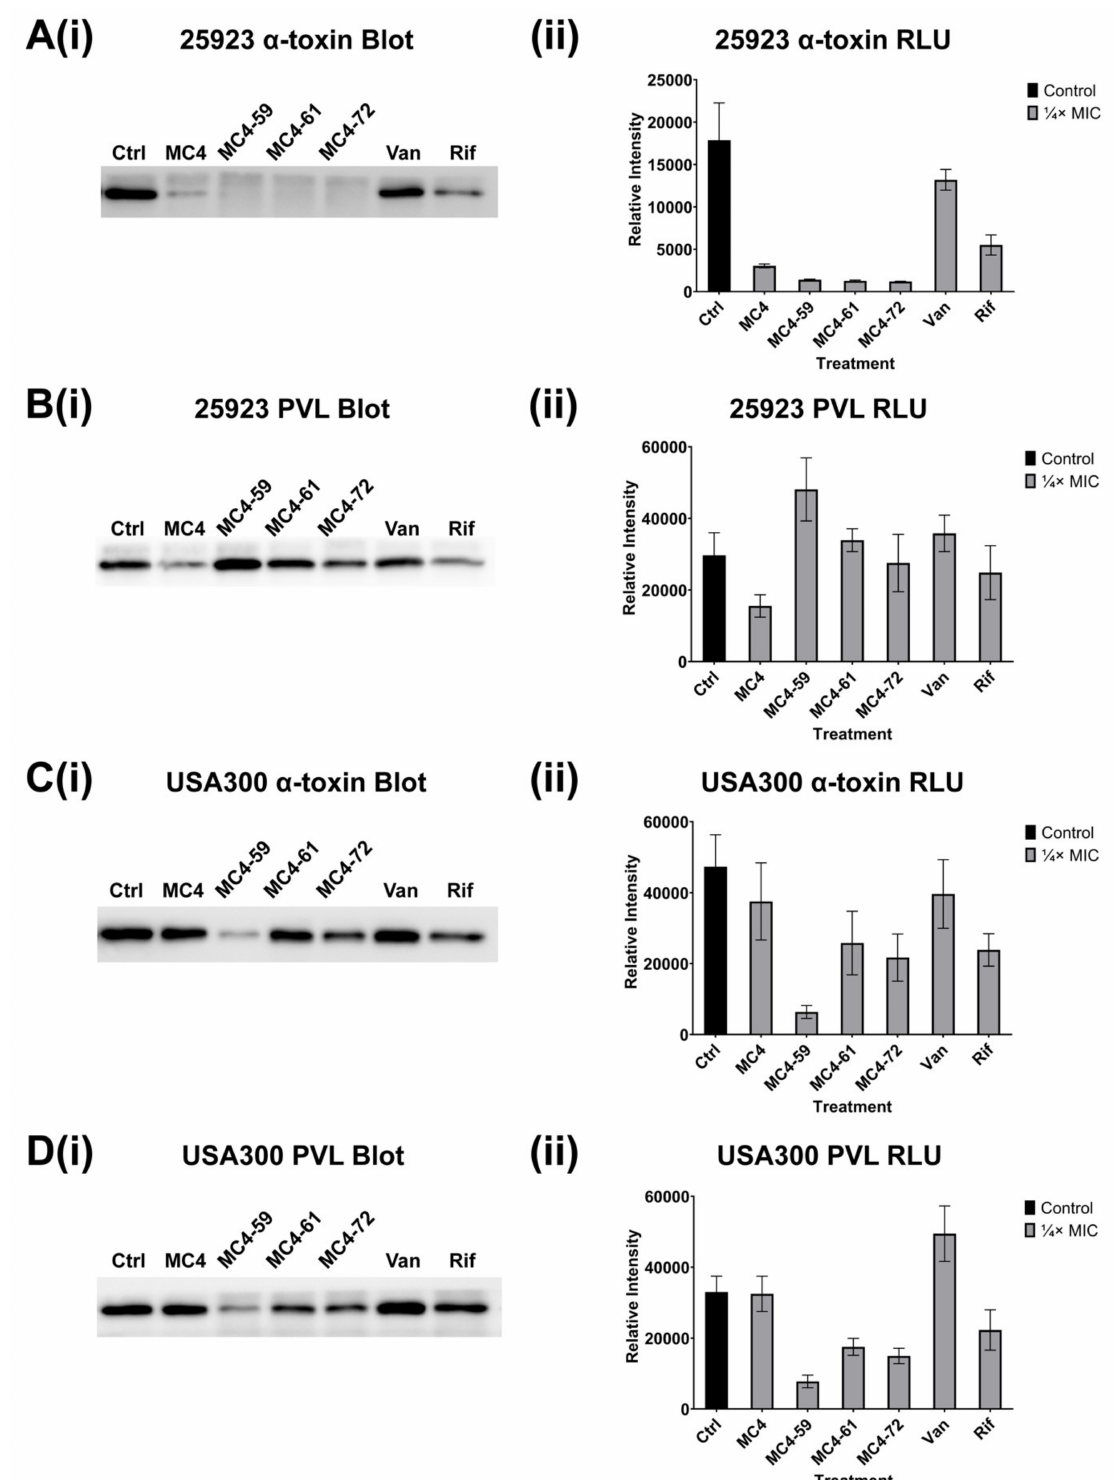
Figure 4. Western blot analysis of the e ff ects of selected nusbiarylins in the expression of ( A ) α -toxin and ( B ) Panton–Valentine Leukocidin (PVL) in S. aureus ATCC ® 25923; ( C ) α -toxin and ( D ) PVL in MRSA USA300 at subinhibitory concentration, presented as ( i ) blot image and ( ii ) relative intensity. Each experiment was performed in triplicates and representative figures shown. 25923: S. aureus ATCC ® 25923; USA300: CA-MRSA strain USA300; Van: vancomycin; Rif: